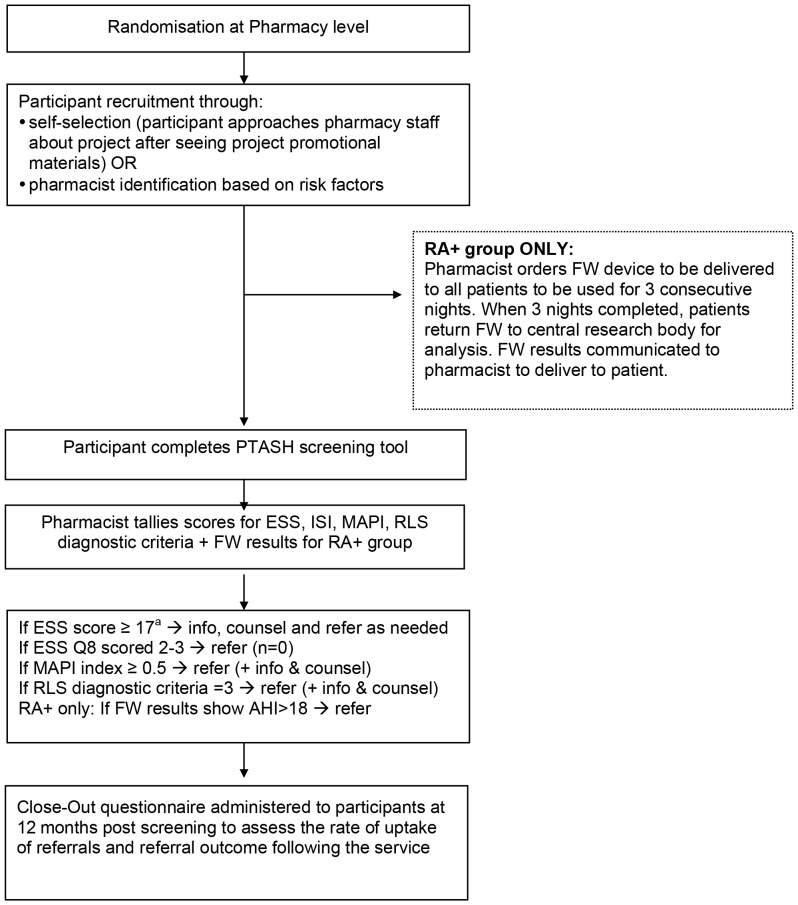
Project protocol for recruitment, screening, and referral and/or counselling of participants according to risk scores.Risk scores were obtained from the PTASH screening questionnaire and the FlowWizard (as an objective marker of SDB). a Clinical cut-off [22]–[23] RA+  =  Risk Assessment Plus, FW =  FlowWizard (nasal flow monitor) ESS =  Epworth Sleepiness Scale ISI =  Insomnia Severity Index MAPI =  Multivariate Sleep Apnea Prediction Index RLS =  Restless Legs Syndrome Info =  provision of sleep disorder specific written information AHI =  Apnea Hypopnoea Index PTASH =  Pharmacy Tool for Assessment of Sleep Health SDB =  sleep disordered breathing.